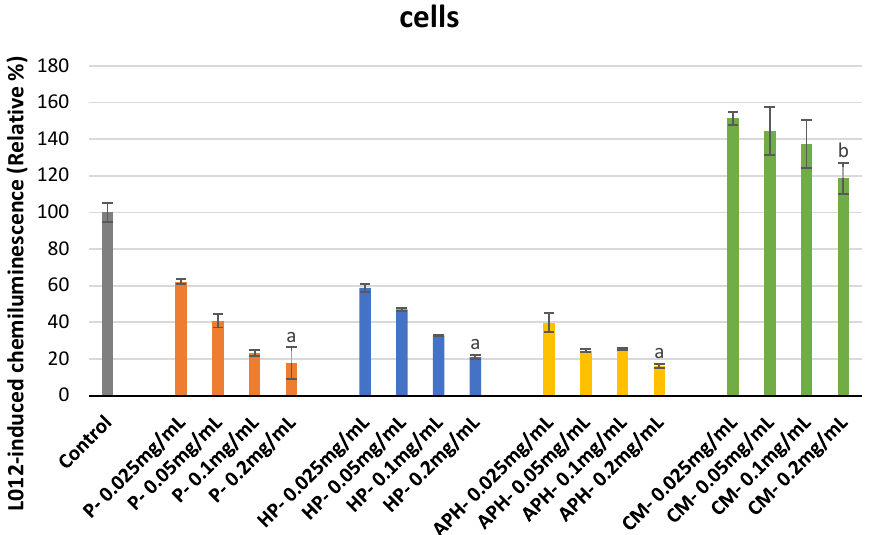
Figure 4. ROS production modulation in PMA-activated HL-60 cells after exposure to P (water- soluble extract of pasteurized minced meat of BSFL), HP (water-soluble extract of hydrolyzed and pasteurized minced meat of BSFL), APH (hydrolysate of water-soluble BSFL proteins), and CM (wa- ter-soluble extract of chicken meal). Results expressed as mean ± standard deviation (n = 3). Differ- ences in the letters above the bars (a and b) represent significant differences ( p < 0.05) in prevention of ROS production (via PMA activated HL-60 cells) by different samples analyzed during this assay.